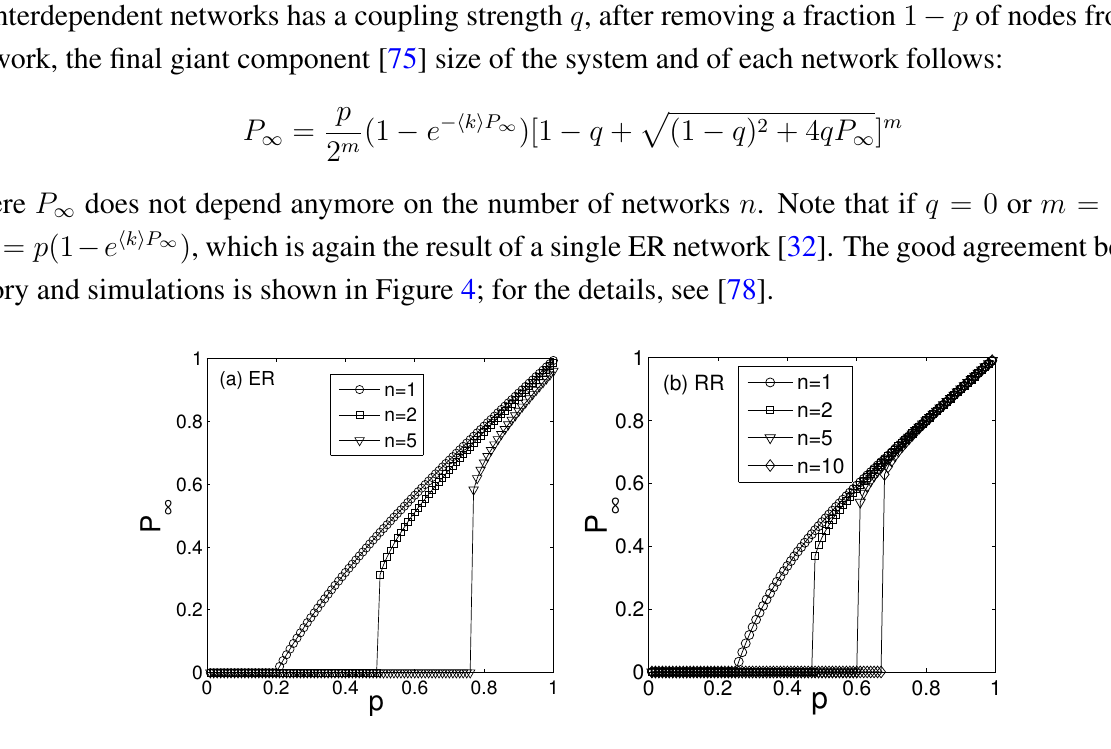
Figure 3. The tree-like NON is composed of ( a ) Erd˝os–Rényi (ER) networks and ( b ) random regular (RR) networks. Plotted is P as a function of p for k = 5 for RR networks ∞ composed of (a) ER and (b) RR networks for several values of n . The results obtained using Equation (4) for ER networks and Equation (5) for RR networks (lines) agree well with the simulations (symbols). After [76].